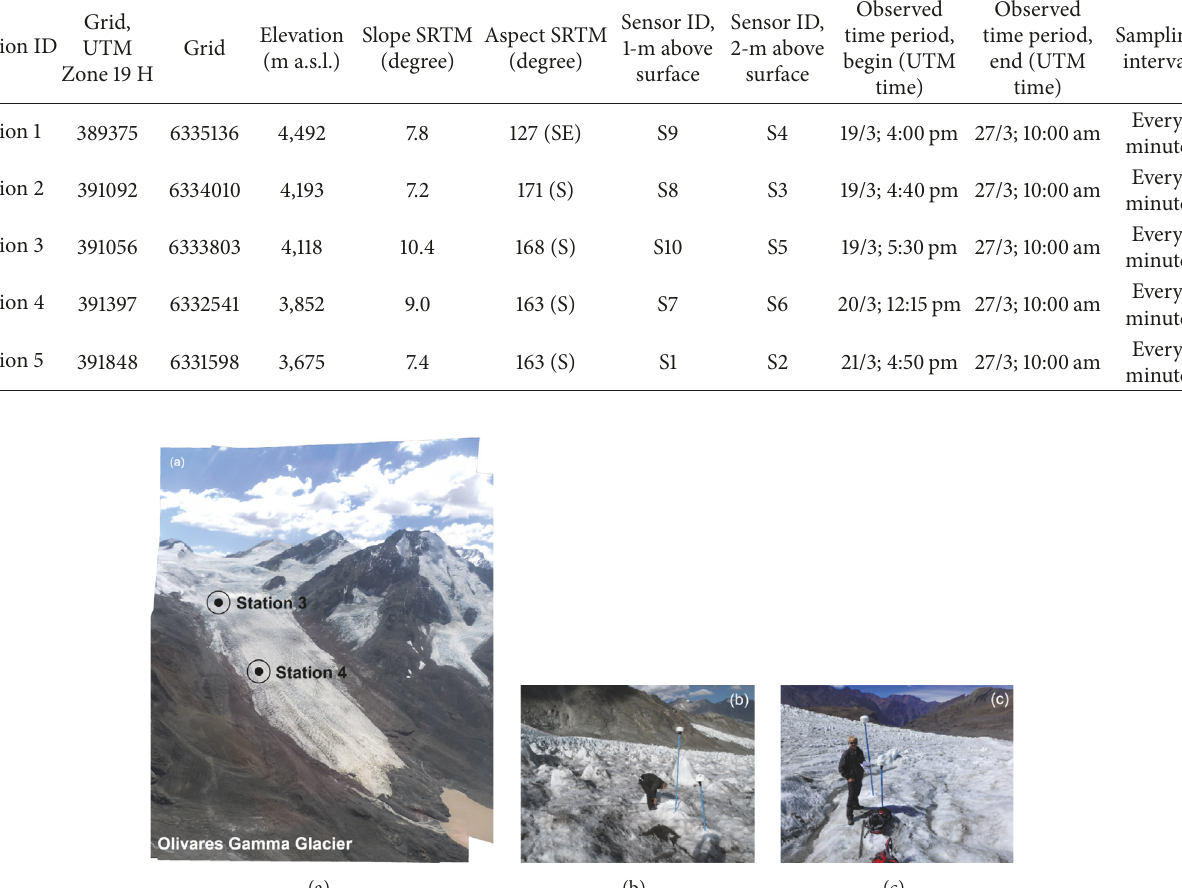
Figure 2: (a) Photos of Olivares Gamma Glacier taken from drone looking north [the distance between Stations 3 and 4 is approximately one kilometre]; (b) Station 3 at 4,118-m elevation with Tinytag sensors 10 and 5 at 1m and 2m heights; (c) Station 4 at 3,852-m elevation with Tinytag sensors 7 and 6 at 1m and 2 m heights. Photo (a) was stitched together and (b) was taken by J. C. Yde and (c) by E.